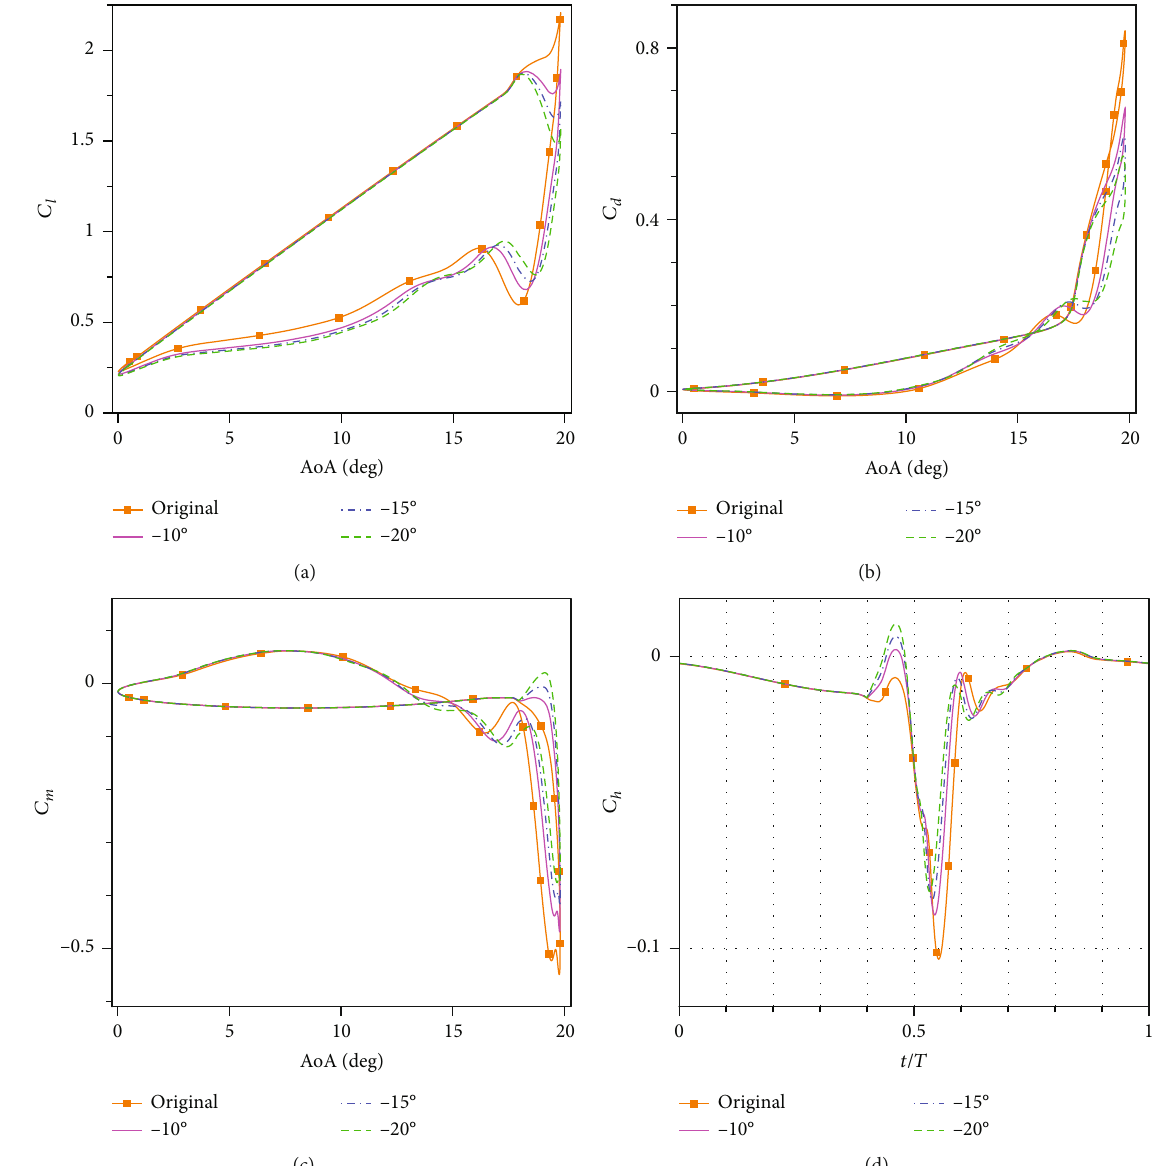
Figure 27: Comparison of aerodynamic force coe ffi cients at di ff erent minimum de fl ection angles of the TEF: (a) lift coe ffi cients, (b) drag coe ffi cients, (c) pitching moment coe ffi cients, and (d) hinge moment coe ffi